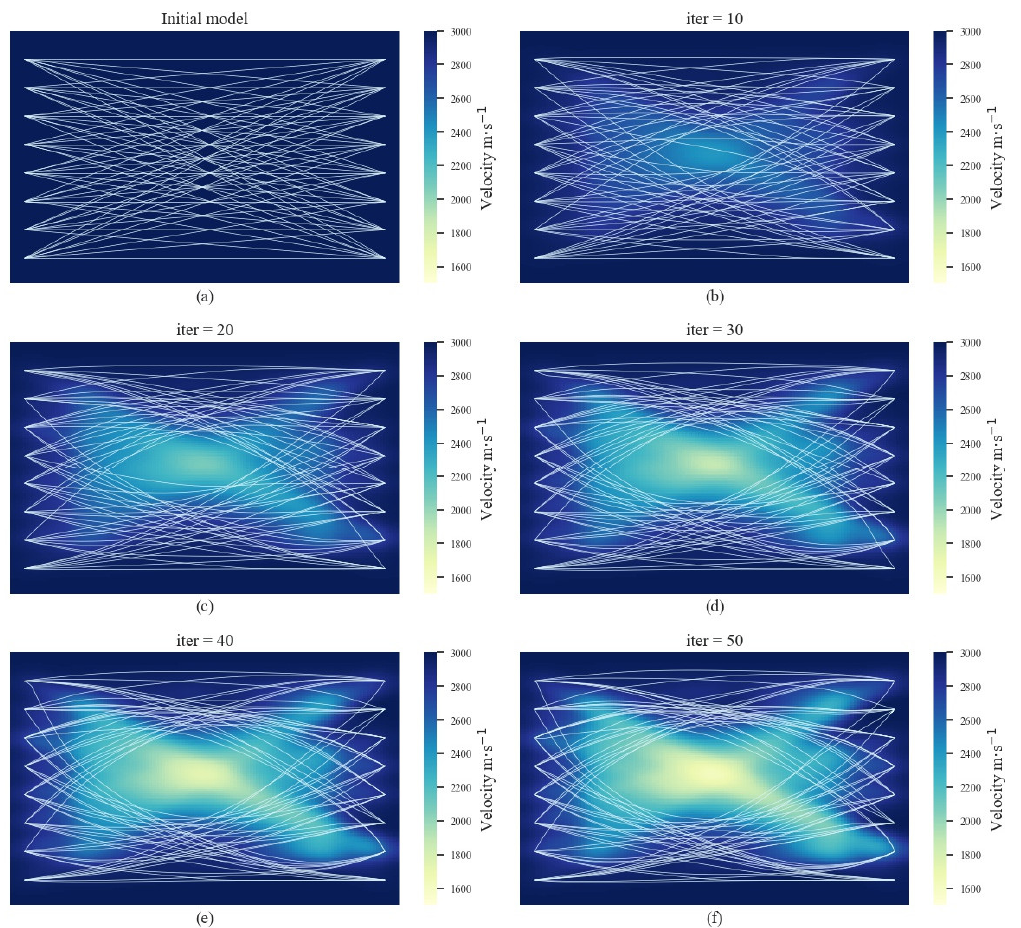
Figure 7. The iteration results of AE tomography in the laboratory experiments. ( a – f ) show the iteration results from the initial model to the 50th iteration. iteration results from the initial model to the 50th